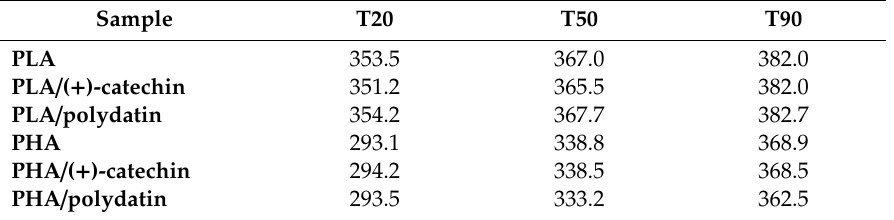
Table 3. T20, T50, and T90 of the samples.